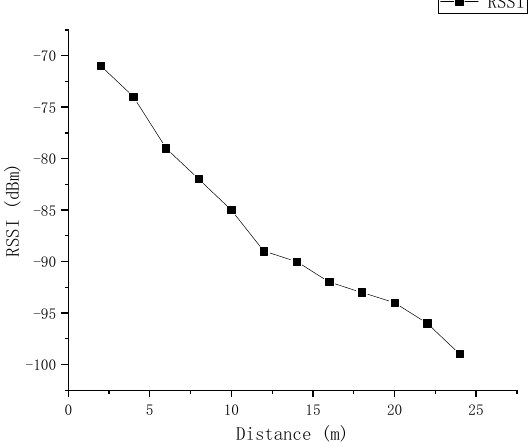
Figure 8. The relationship between Received Signal Strength Indication (RSSI) and distance.